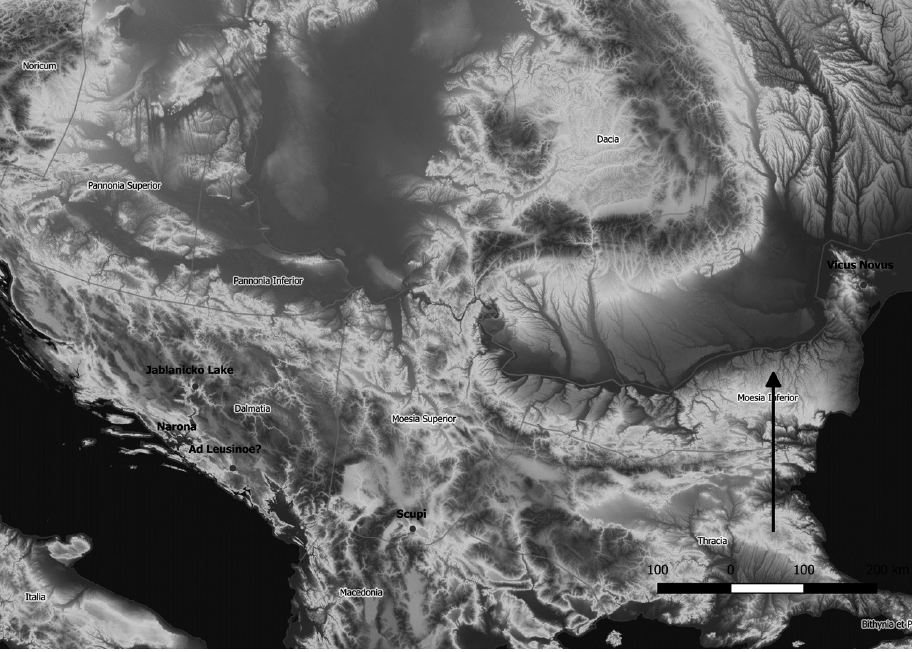
Figure 2: A general map of the study-area with the locations of the case